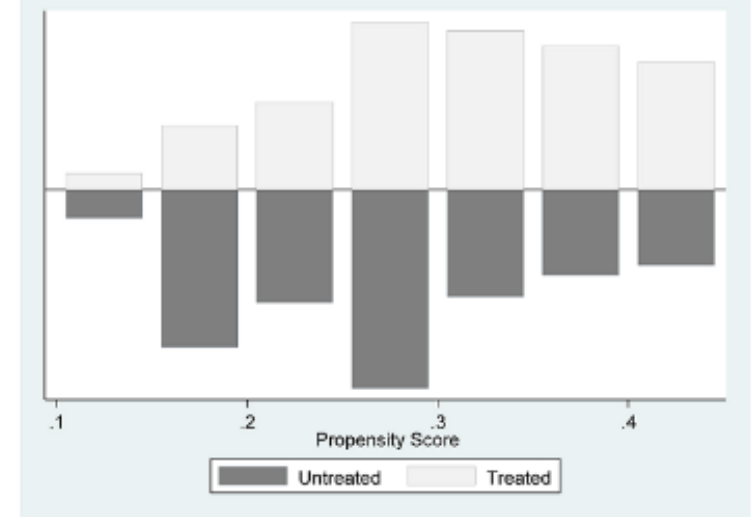
Figure 1. Distribution of propensity score between treated and untreated